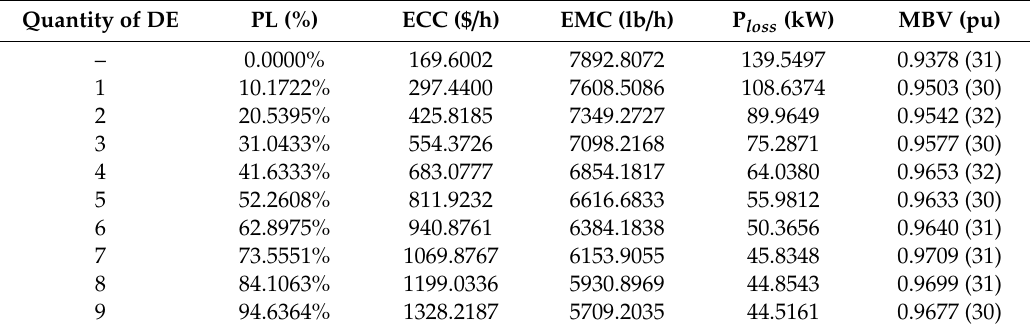
Table 6. Reconfiguration results of the increasing diesel engine (DE)